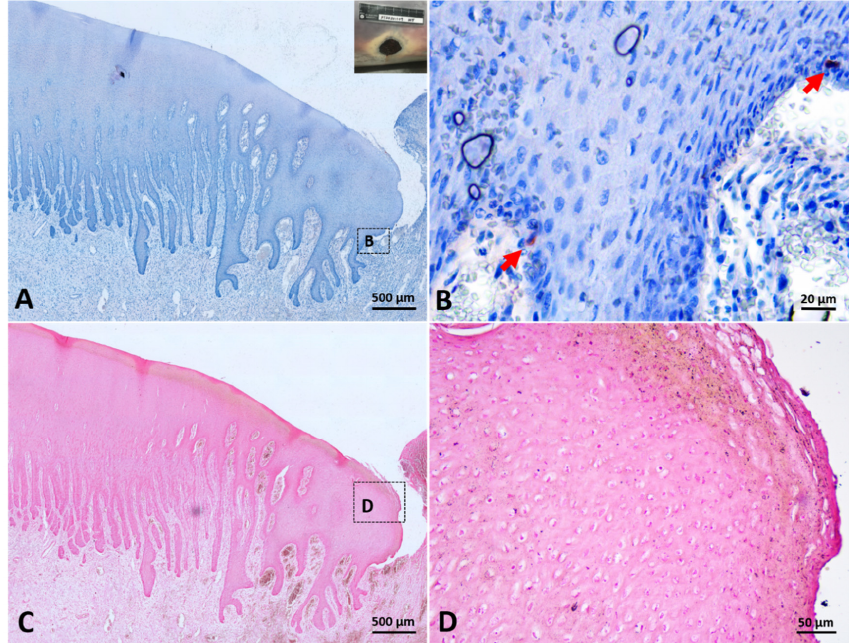
Figure 4. The distribution of melanocytes and melanin in a stage 3 wound collected from white skin region. ( A , B ): Immunohistochemical staining with cocktail antibody. Few melanocytes (arrow) were present in the basal layer of neoepidermis, including leading edge of migrating epithelial tongue. ( C , D ): Fontana–Masson staining. Scarce melanin granules were distributed throughout the neoepi- dermis, including the stratum externum of leading edge of migrating epithelial tongue.